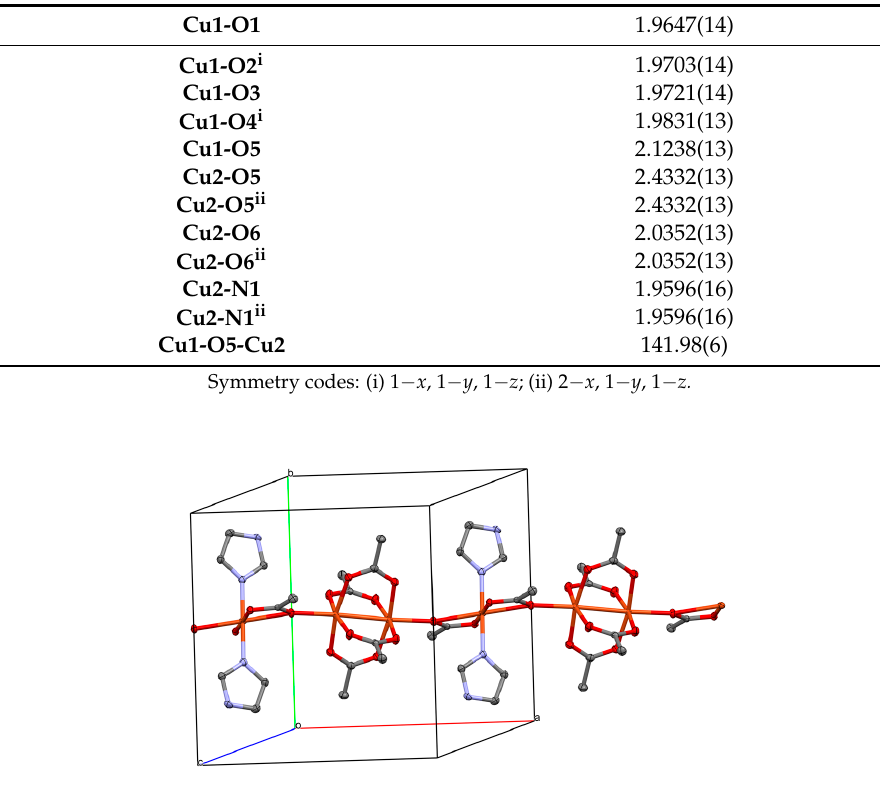
Table 1. Selected Bond Lengths (Å) and Angles ( o ).